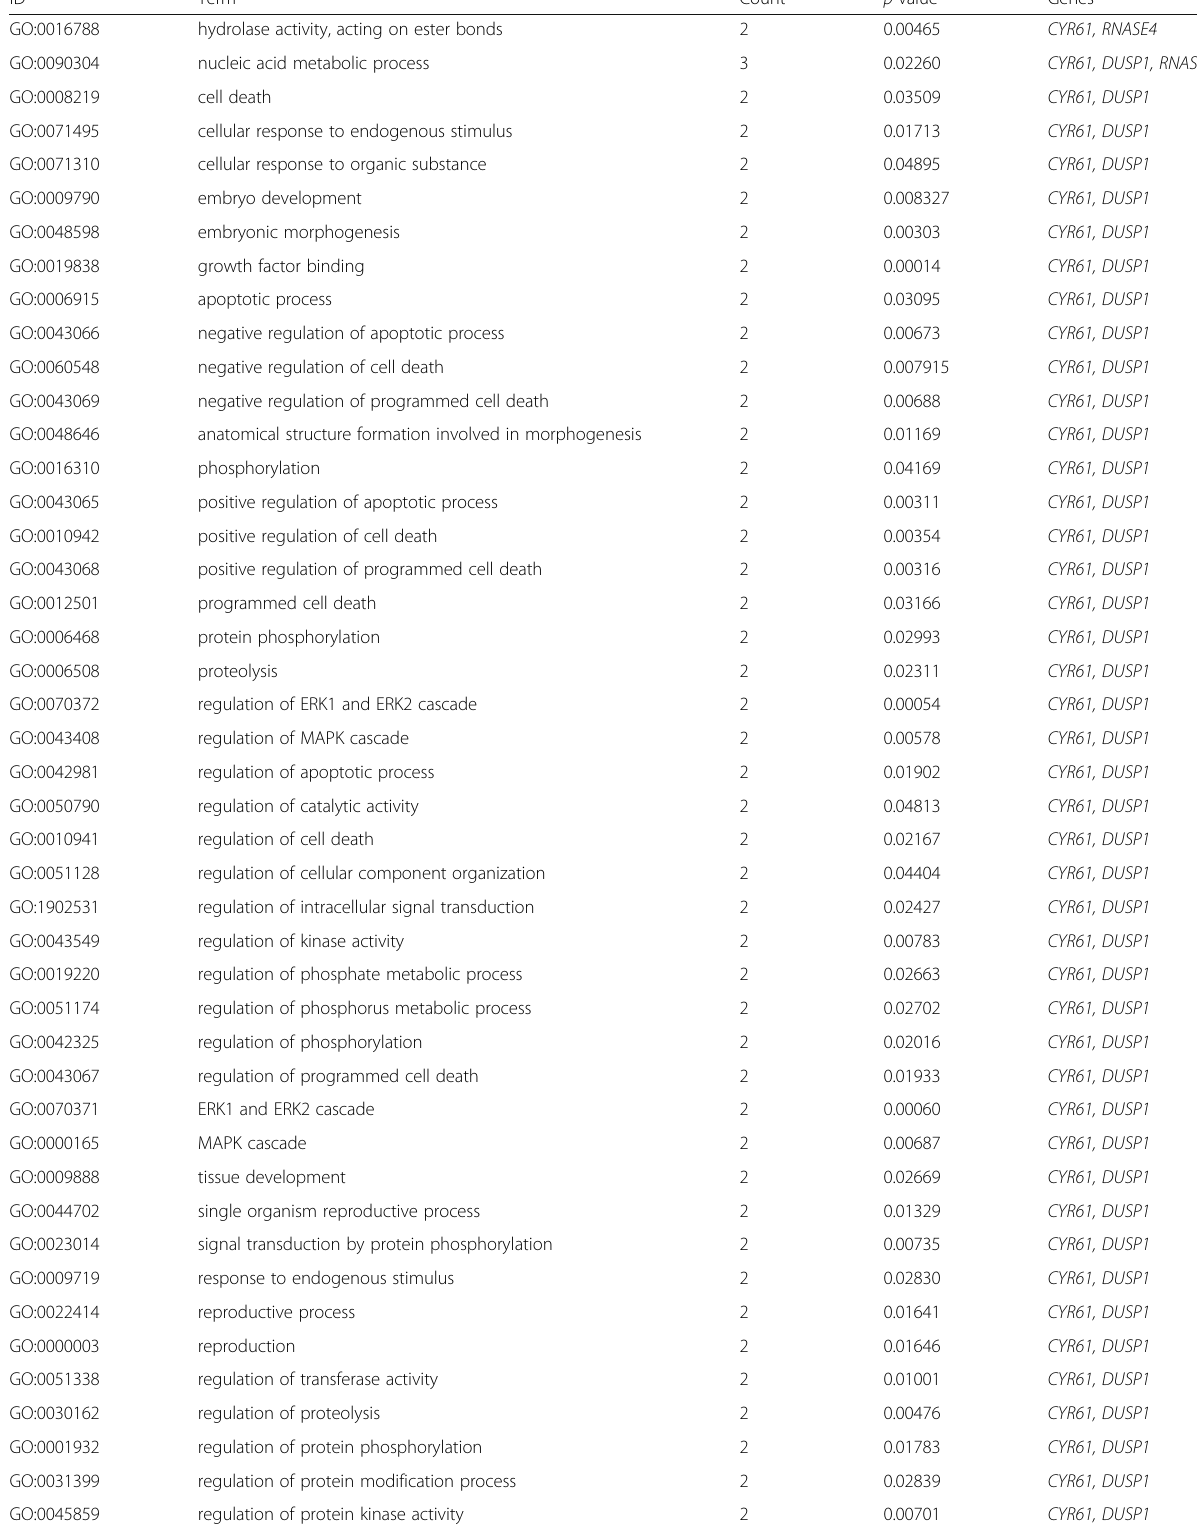
Table 2 The gene ontology analysis of potential key genes in